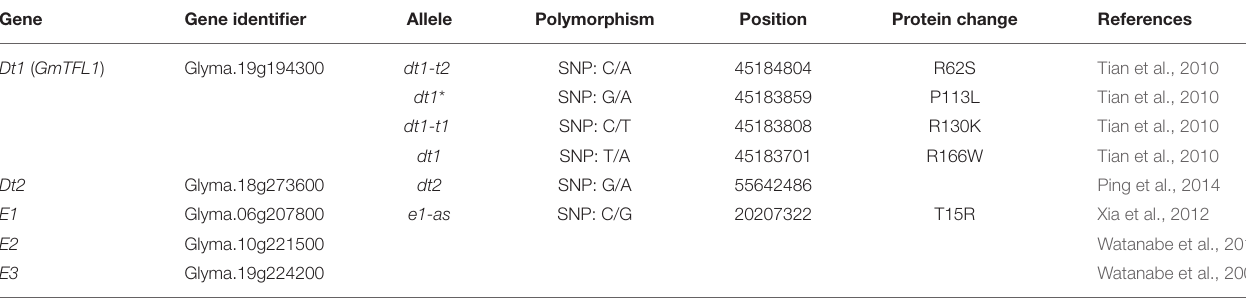
TABLE 1 | Description of alleles and genes controlling stem termination type and maturity used in this study.